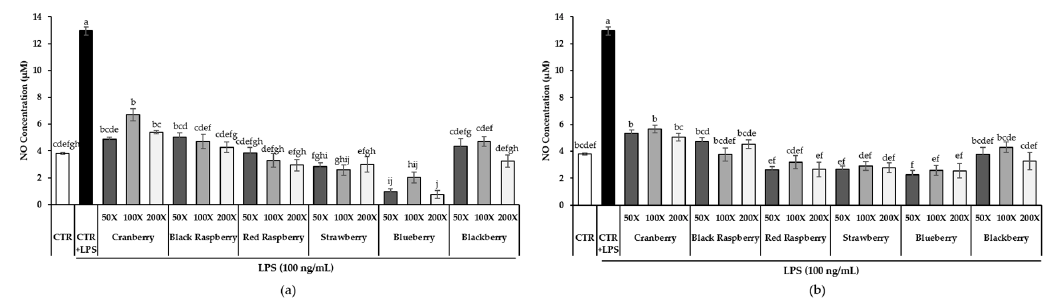
Figure 2. The production of nitric oxide (NO) in RAW264.7 cells treated with 6 ( a ) berry phenolic and ( b ) berry volatile extracts (50, 100 and 200-fold dilutions). Data are expressed as the mean ± SEM ( n = 10). Means followed by a common letter are not significantly different by the Tukey’s test at the 5% level of significance. CTR = control.